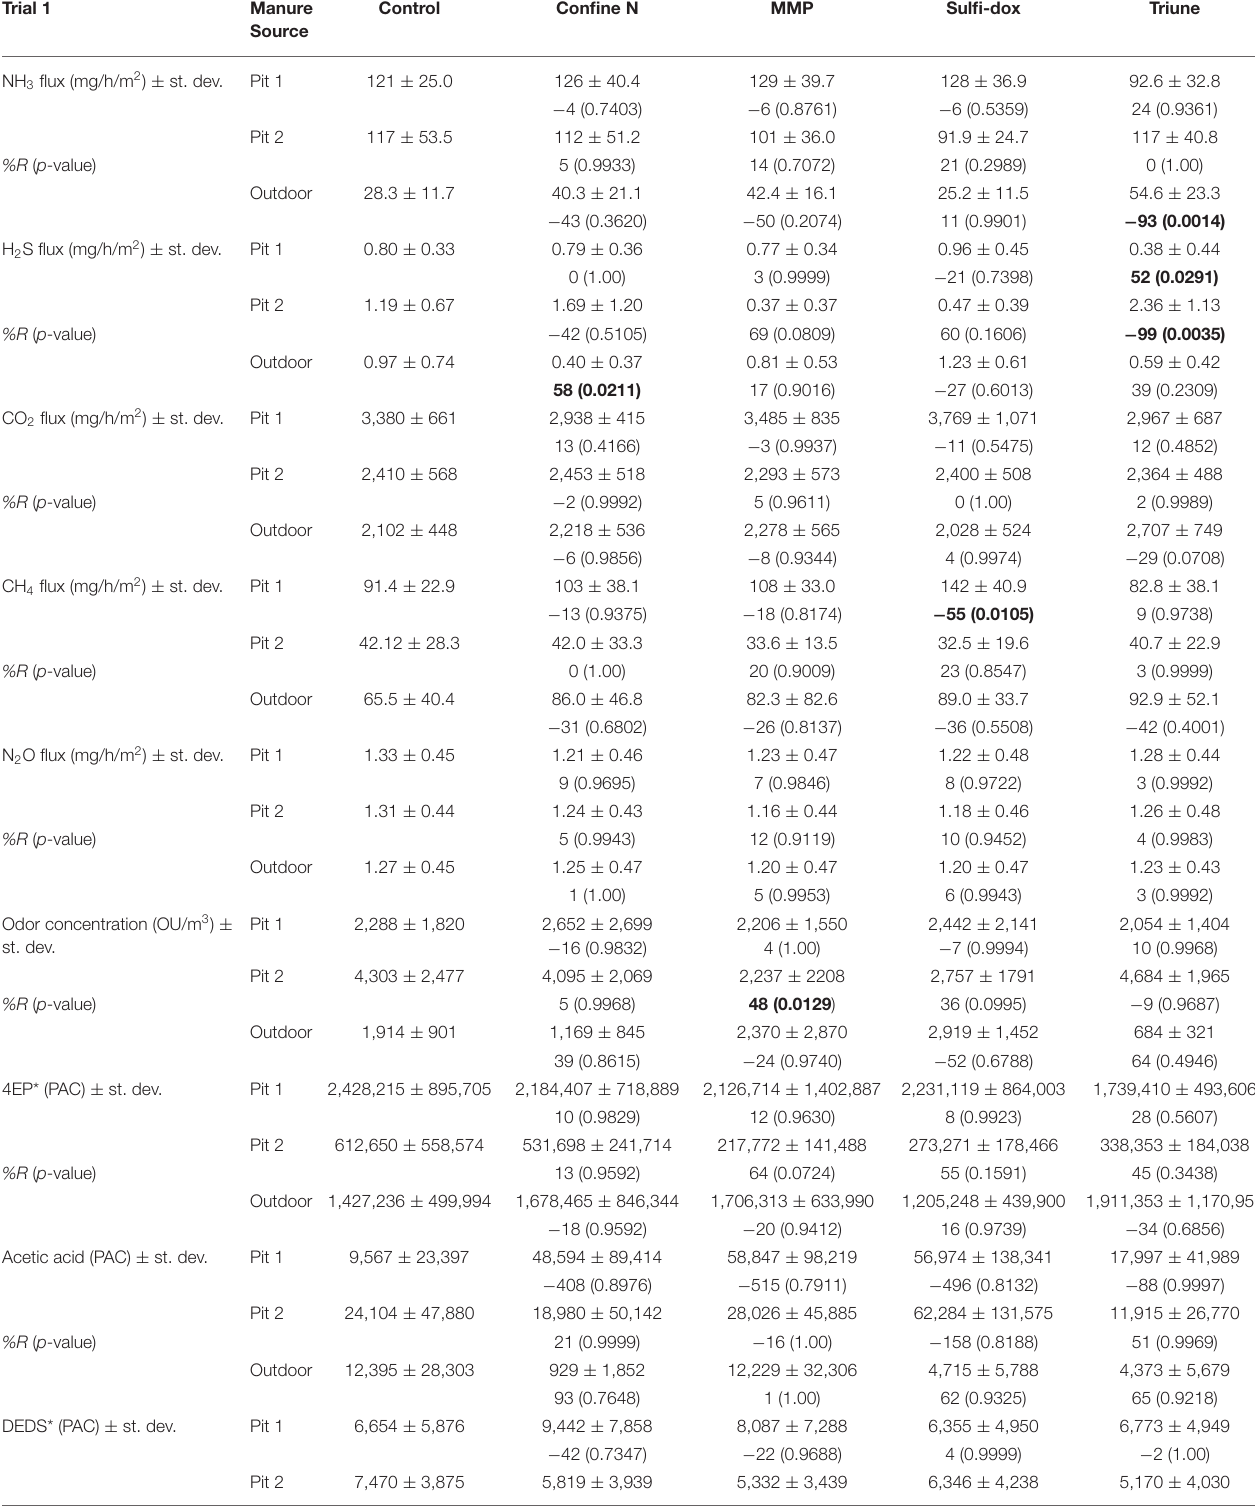
TABLE 3 | Trial 1-comparison of averaged gaseous emissions (flux or arbitrary units for VOCs) and percent reductions ( %R ) analyzed separately for each type of manure sources (farms) with their standard deviations. Trial